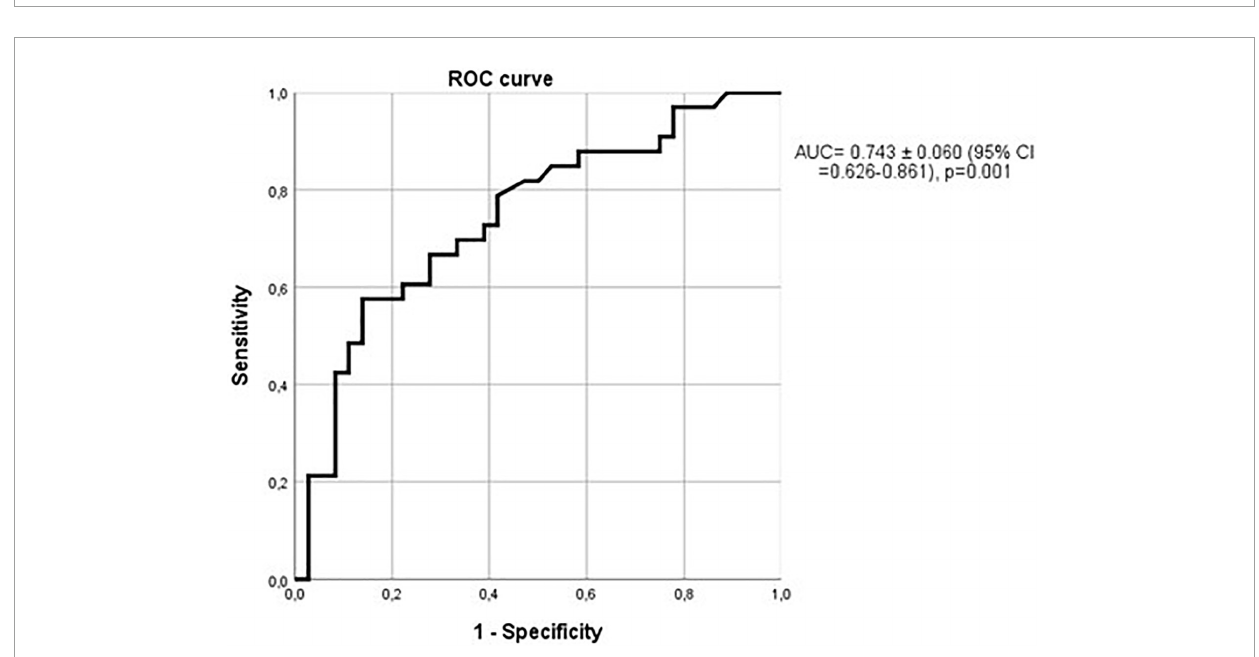
FIGURE12 Relationship between sclerostin and cella media values over the median in non-hypertensive patients. ROC curve with an AUC = 0.743 ± 0.060 (95% CI = 0.626–0.861); p = 0.001.